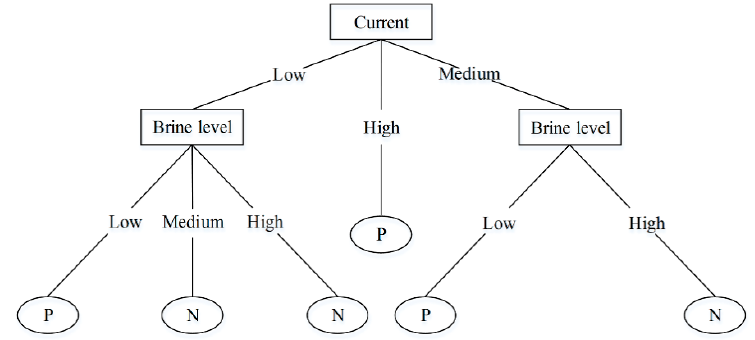
Figure 7. Decision tree for fault classification of brine pump.